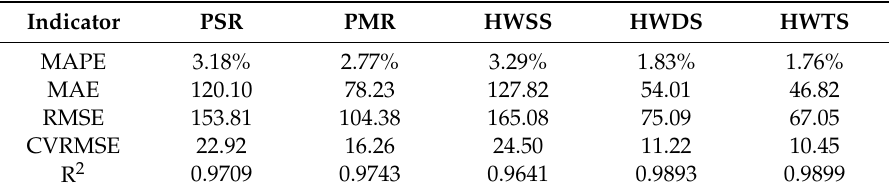
Table 3. The calculated values of di ff erent performance statistical metrics for the used models.